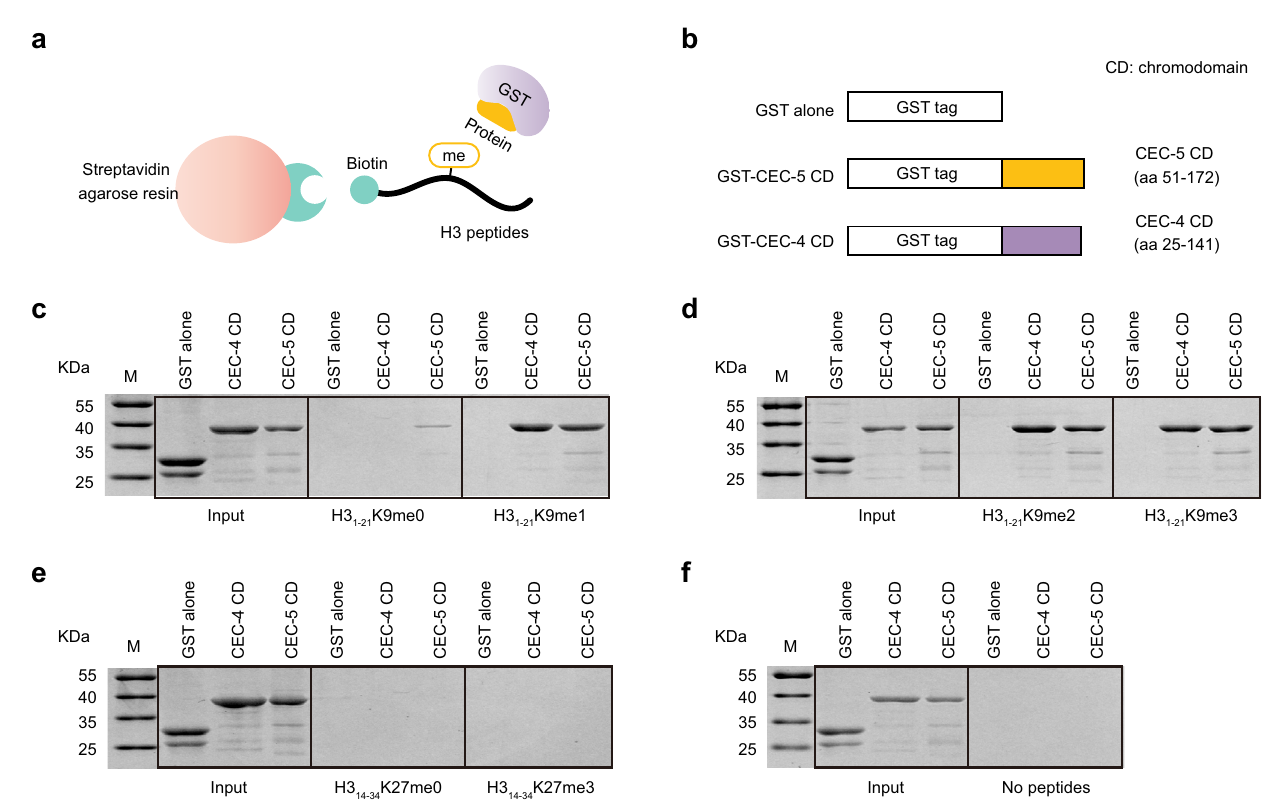
H3K27me3 peptides (Fig. 6e, f). CEC-5 did not bind either H3K27me0 or H3K27me3 peptide (Fig. 6e, f). Surprisingly, CEC-5 bound both unme- thylated (me0) and methylated (me1/2/3) H3K9 peptides (Fig. 6c, d).